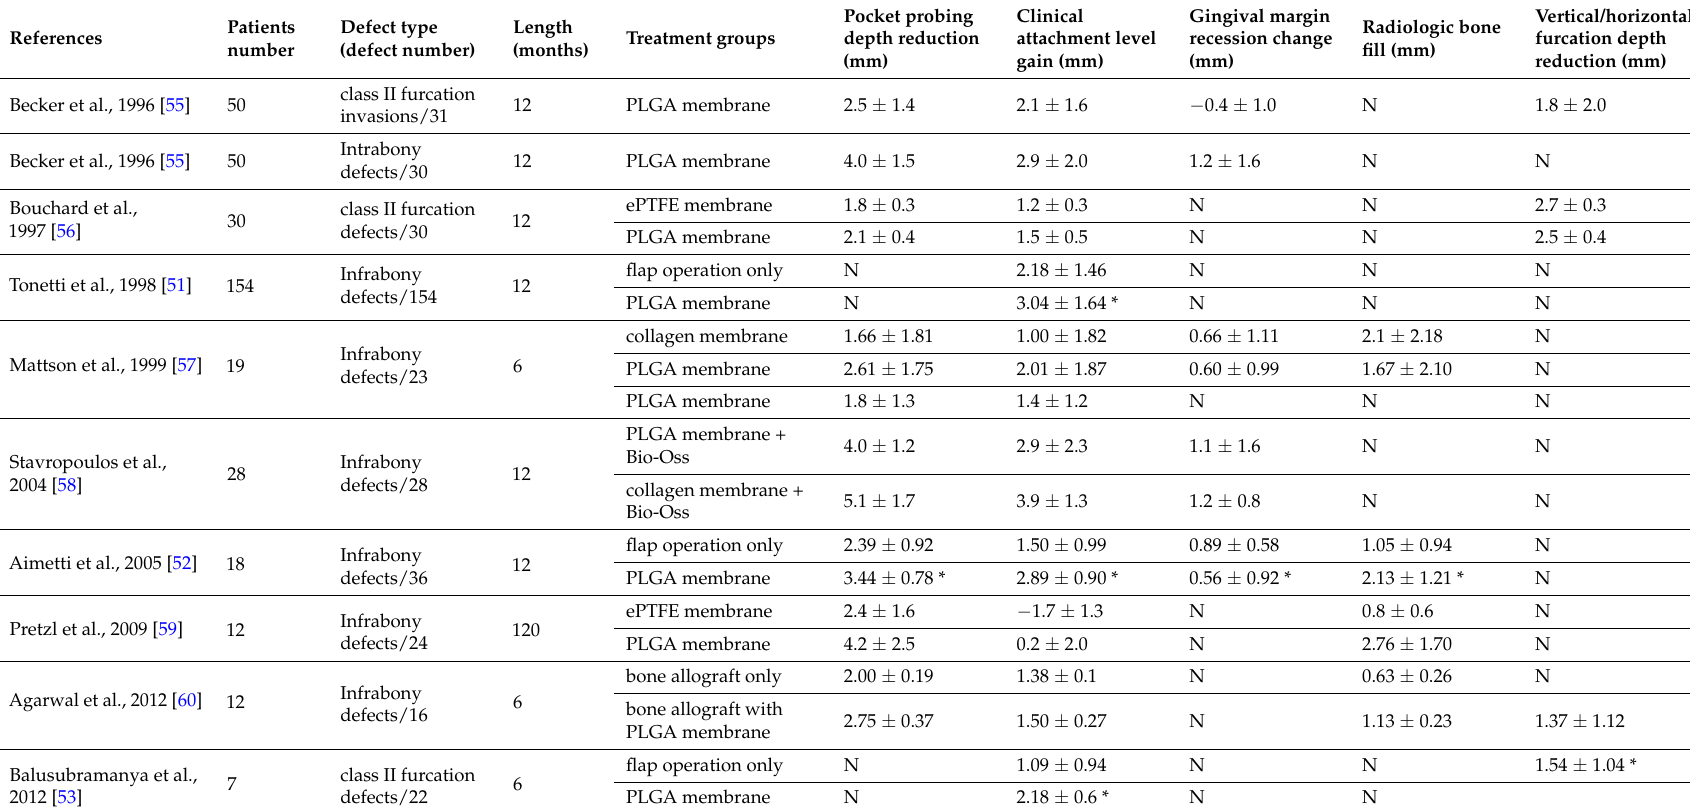
Table 3. Clinical results of PLGA membranes for periodontal